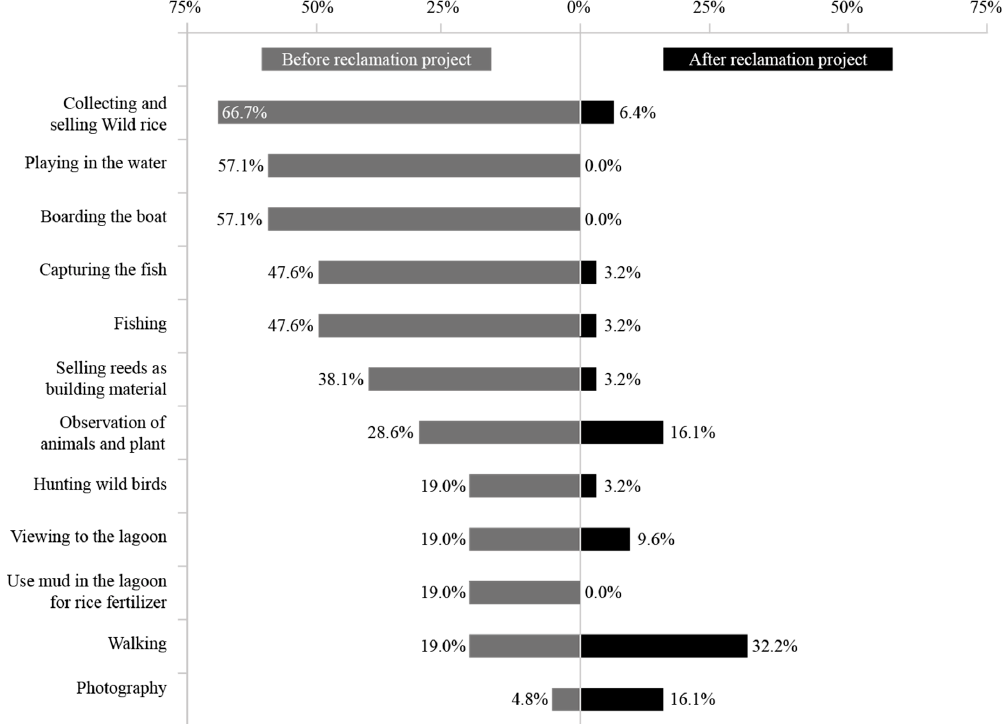
Figure 9. The actual situation of uses of the Fukushima-gata lagoon before and after the reclamation project (n = 31).